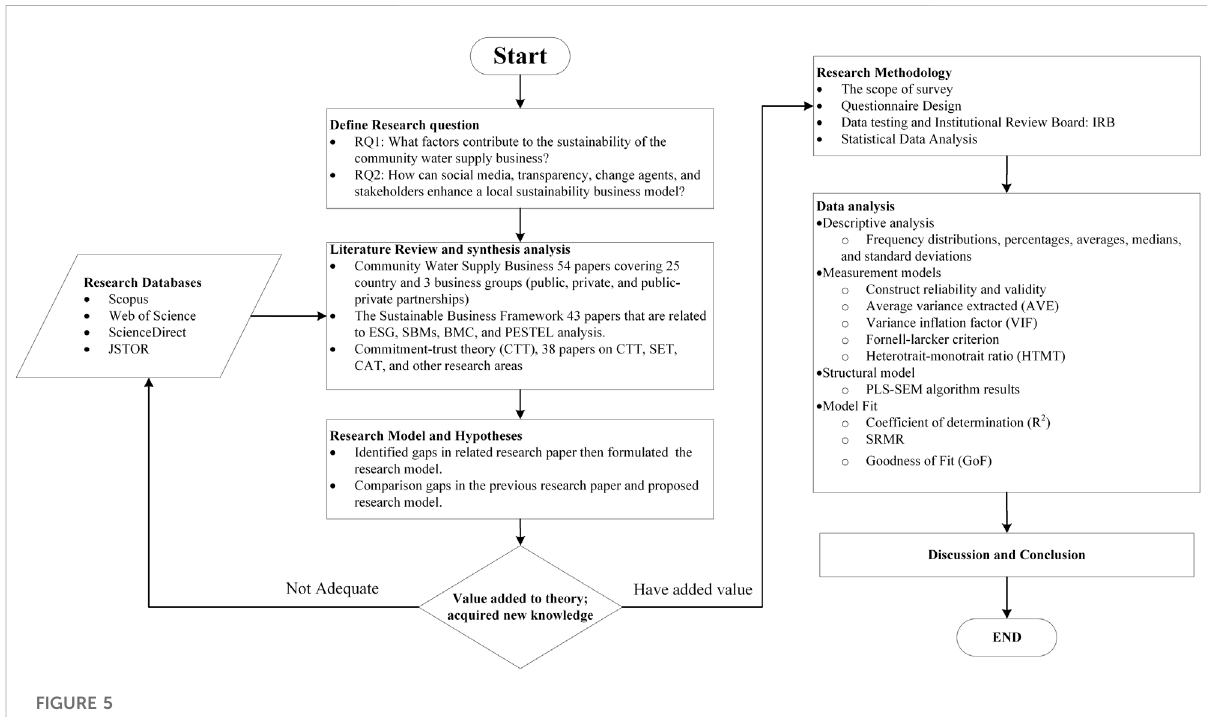
FIGURE 5 Flowcharts of research methodology